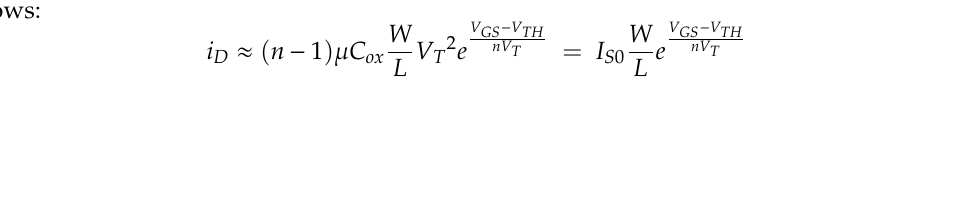
Figure 7. Successive approximation (SAR) analog-to-digital converter (ADC) architecture.